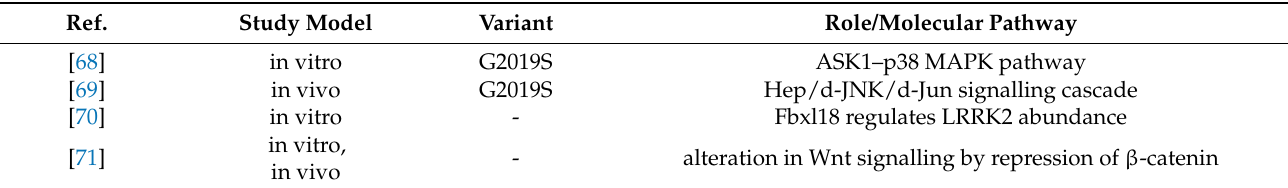
Table 8. LRRK2 and kinase signalling